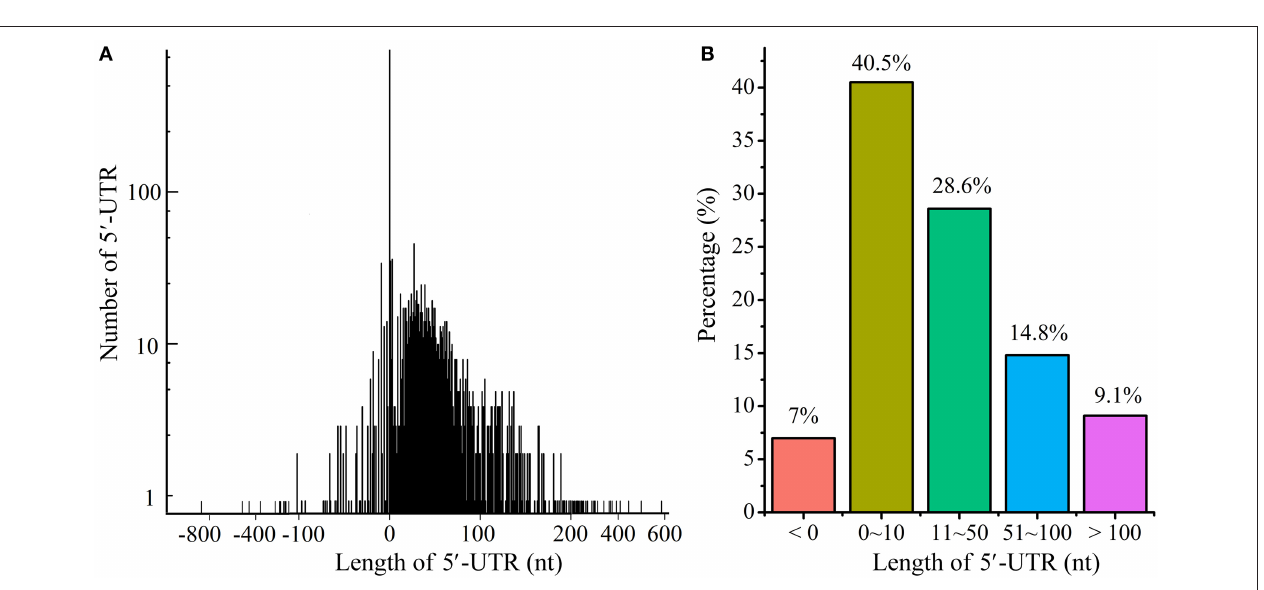
FIGURE 6 | Distribution of 5 ′ -UTRs length. (A) The distribution of 5 ′ -UTRs length. (B) The percentage of 5 ′ -UTRs length. The length of 5 ′ -UTRs < 0 indicated potentially mis-annotated